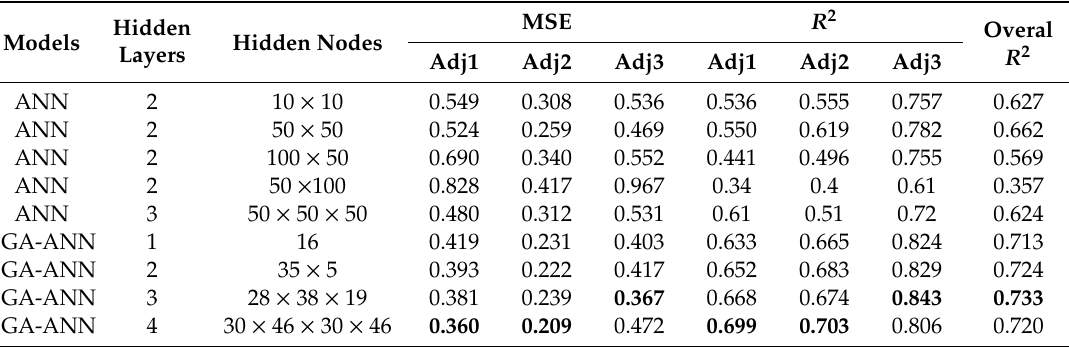
Table 7. Predictive performance of di ff erent GA-based ANN